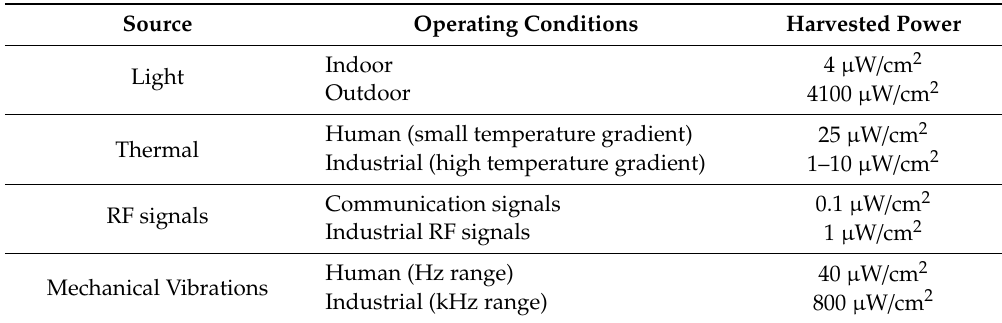
Table 1. Comparison between the estimated power densities for di ff erent typologies of energy sources, both in the indoor and outdoor environments